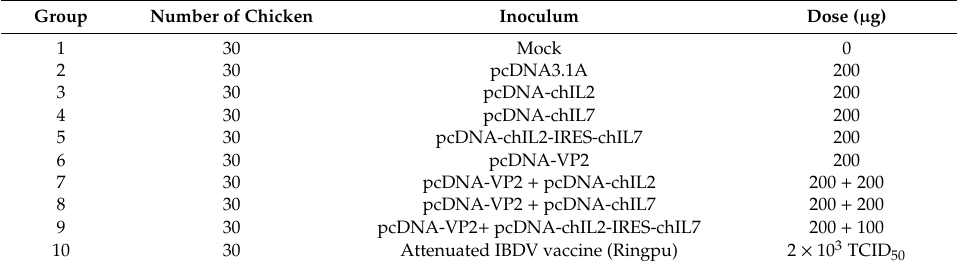
Table 1. Chicken groups and plasmid